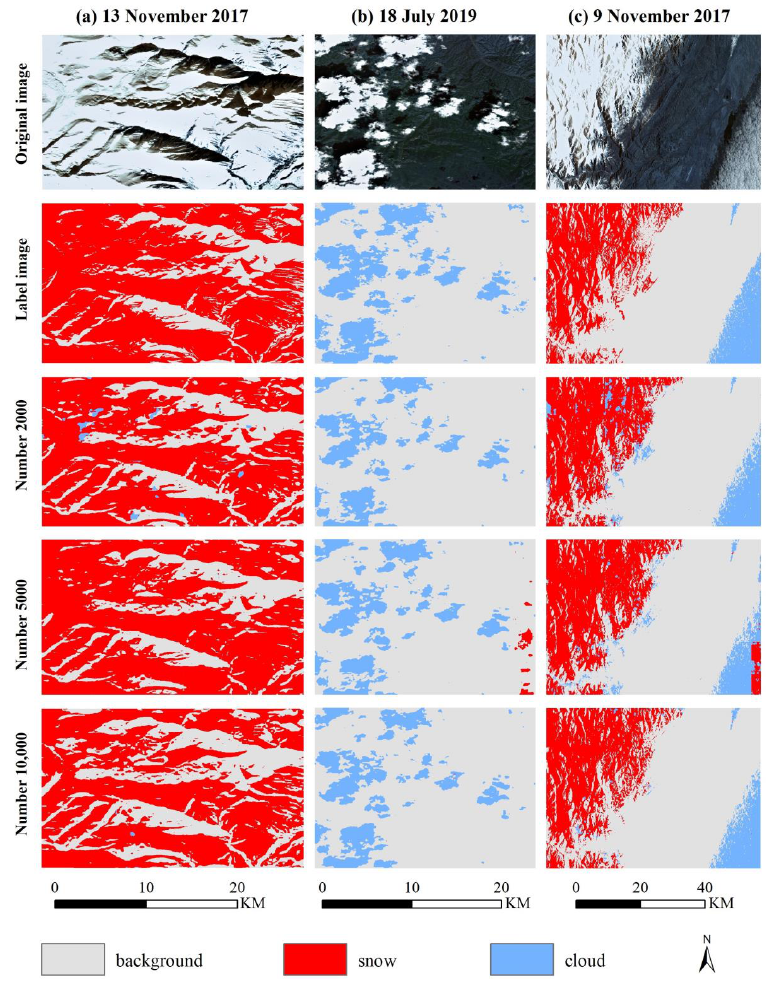
Figure 4. Comparison of cloud and snow identification under different sample numbers. The three columns of subfigures ( a – c ) represent the original image, the label image, and the prediction maps under the sample number of 2000, 5000, and 10,000 at three different dates, respectively.